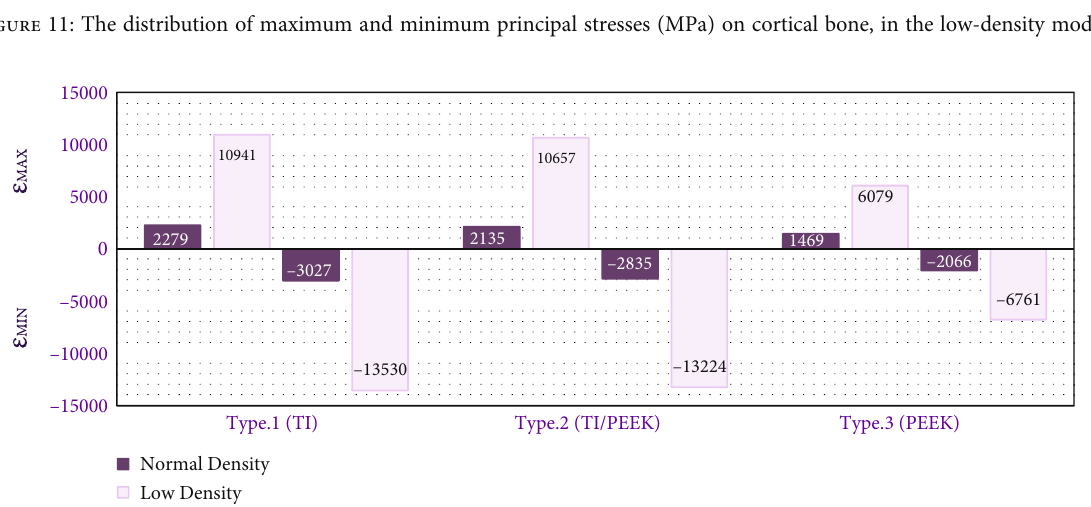
Figure 12: The distribution of maximum and minimum principal stresses (MPa) on cancellous bone, in the low-density model.